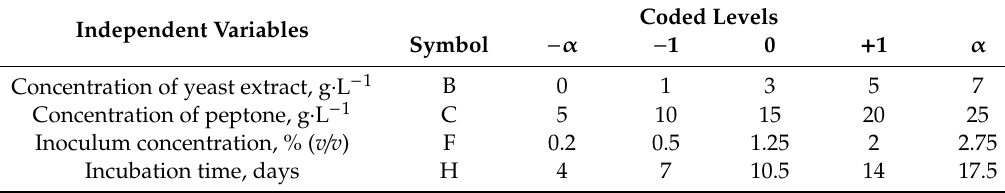
Table 2. Coded and actual values of independent variables used in the RSM. Independent Variables